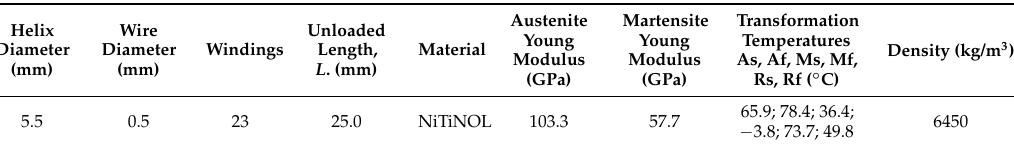
Table 2. SMA spring characteristics [31].